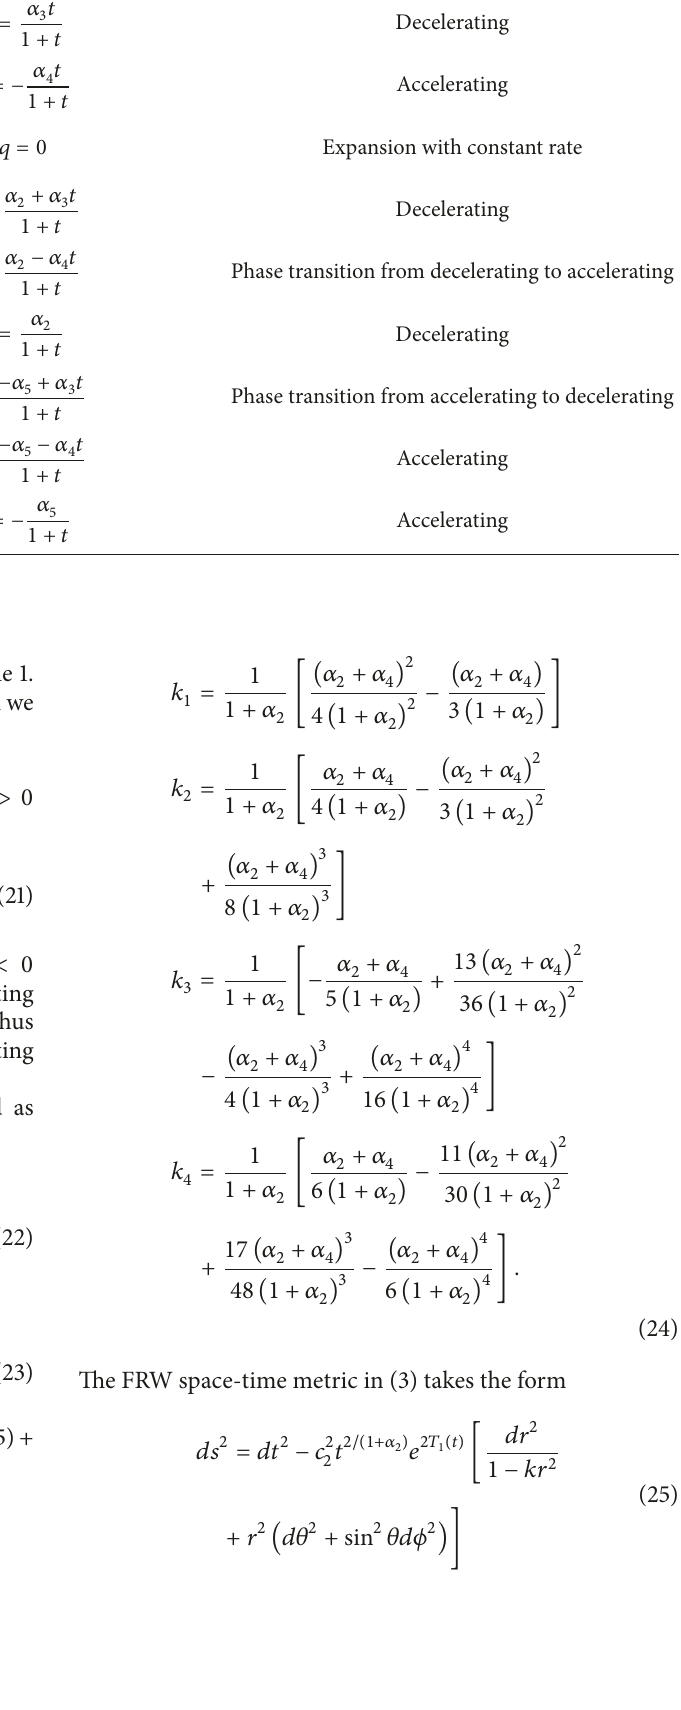
Table 1: Different forms of deceleration parameter depending on the parameters 𝛼 2 and 𝛼 3 and behaviour of cosmological models according to the deceleration parameter 𝑞 . S.